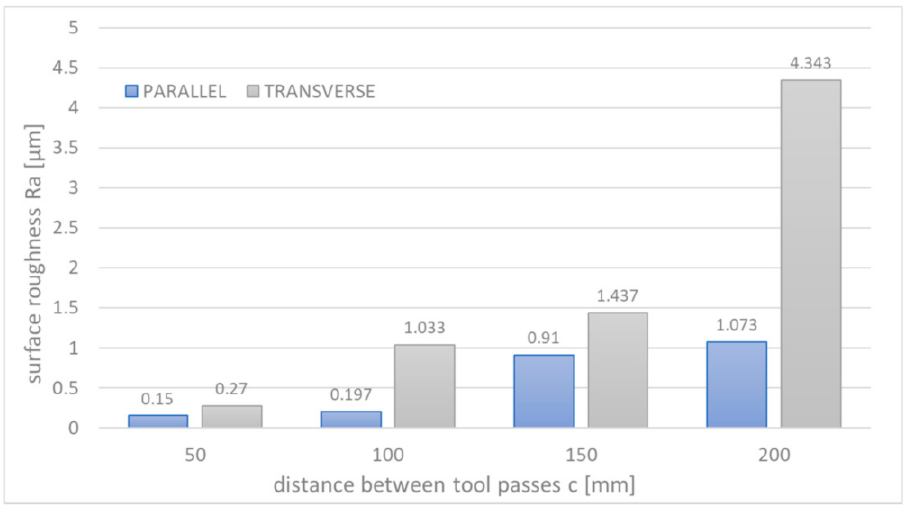
Figure 16. Average values of Ra changes with the distance between passes c ; measured parallel and transverse to the electrode tool